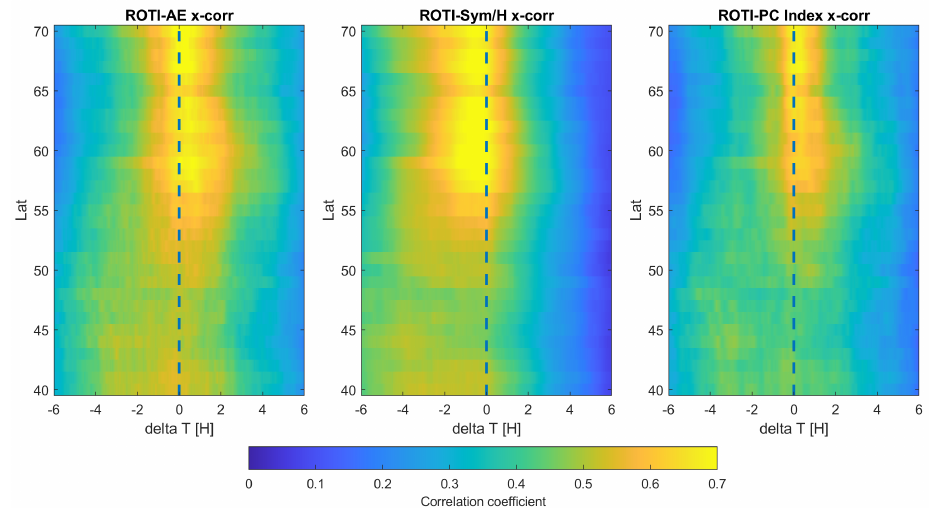
Figure 8. Cross − correlation pattern between ROTI and AE, Sym-H, PC